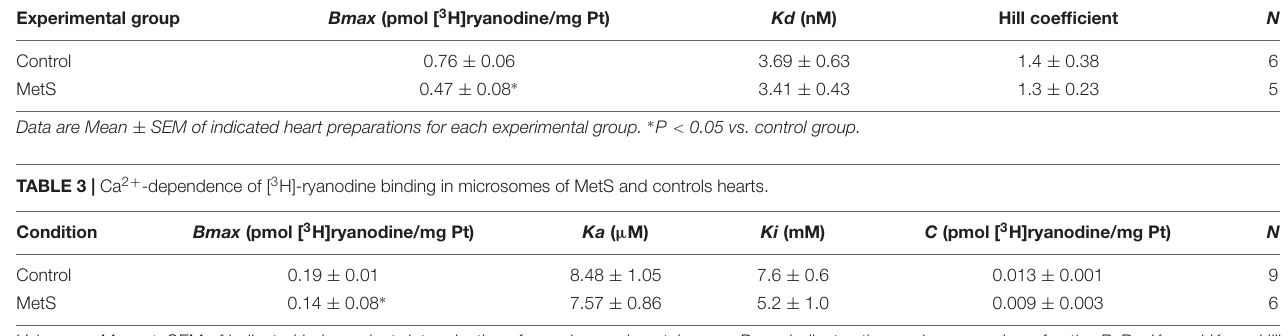
Values are Mean ± SEM of indicated independent determinations for each experimental group. Bmax indicates the maximum number of active RyRs, K a and K i are Hill activation and inactivation constants, respectively; and C is an initial [ 3 H]-ryanodine binding value at very low [Ca 2 + ] (pCa8). N indicates the number of hearts. ∗ P < 0.05 vs. control group.